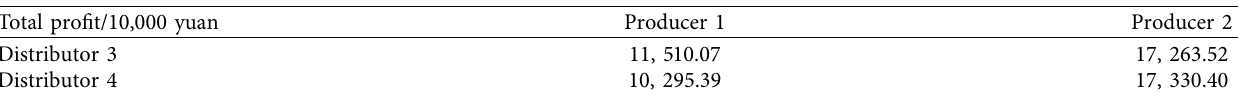
Table 9: Total profits of the producer-distributor subchain through coordinated optimization under the profit-sharing contract under government subsidy.